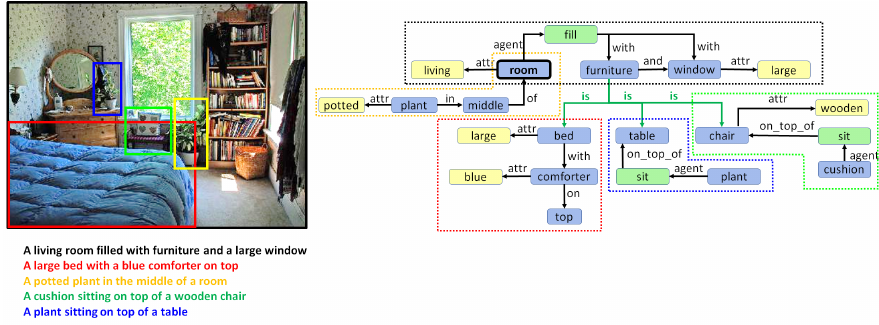
Figure 16. Holistic scene graphs showing distinct instances of plants in disjoint bounding boxes.